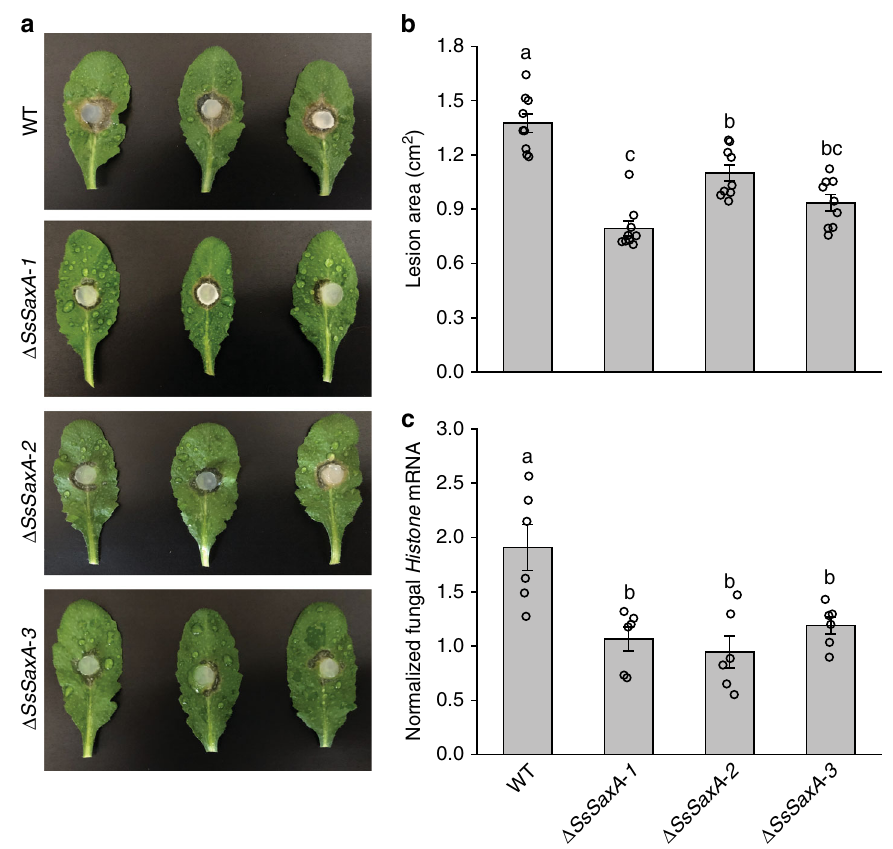
Fig. 7 Δ SsSaxA mutants are signi fi cantly less virulent on A. thaliana Col-0 than the wild-type fungus. a Representative images of A. thaliana Col-0 leaves infected by WT and Δ SsSaxA mutants. b Comparison of lesion area caused by WT and Δ SsSaxA mutants 24 hpi on leaves of A. thaliana . Data represent mean ± SEM ( n = 9 inoculated leaves from separate plants). c Relative growth of WT and Δ SsSaxA mutants on A. thaliana Col-0 as determined by qRT-PCR. The fungal Histone mRNA was normalized to the A. thaliana ACTIN2 mRNA to quantify the relative fungal colonization 24 hpi. Data represent mean ± SEM ( n = 6 independent inoculated plants). Data were analyzed by one-way ANOVA ( p < 0.001) followed by a Tukey ’ s post-hoc test. Different letters above the bars indicate statistically signi fi cant differences at p < 0.05. Source data are provided as a Source data fi